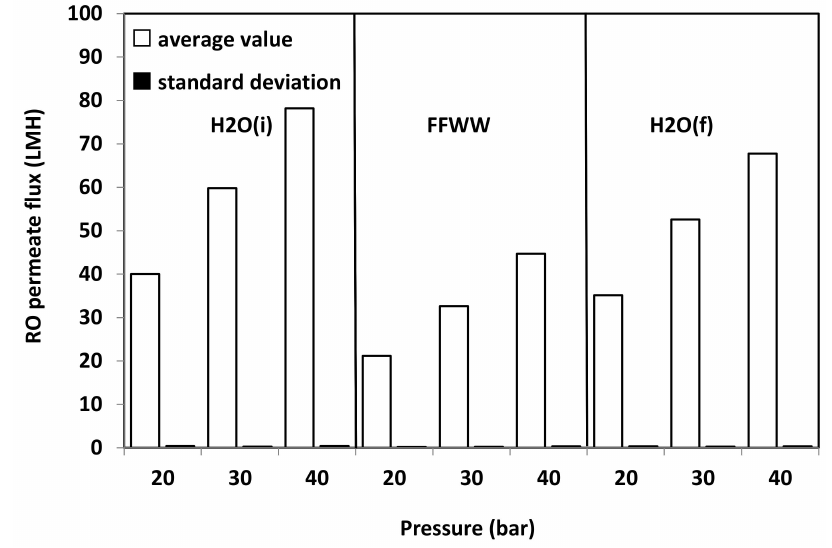
Figure 9. Average RO permeate flux and SD vs. operating pressure of the GEADHR membrane.